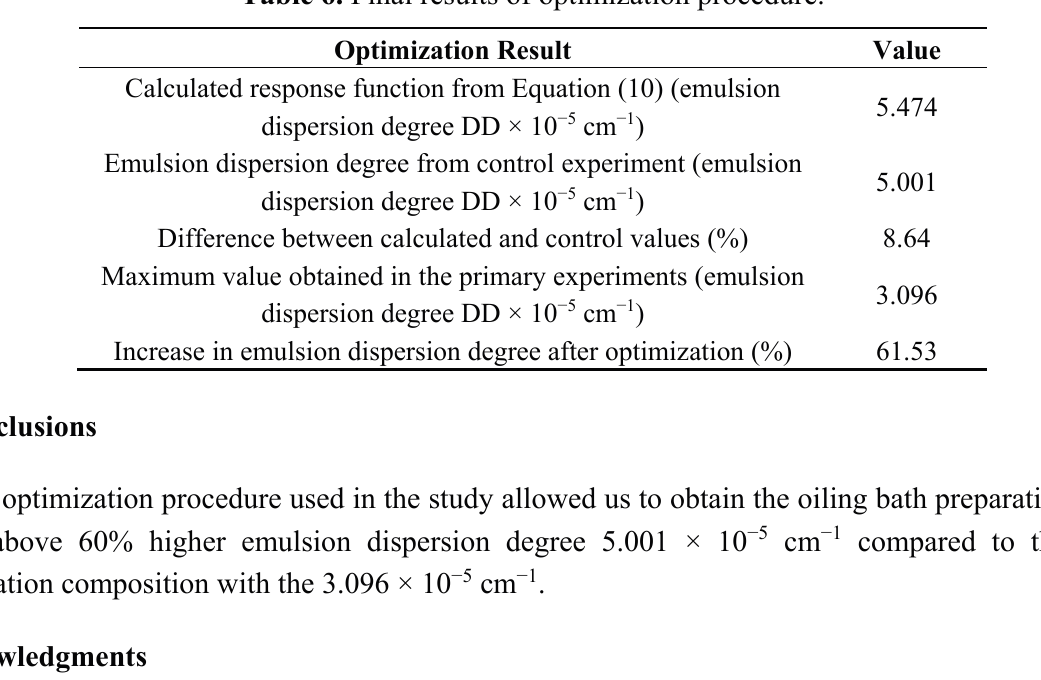
Table 6. Final results of optimization